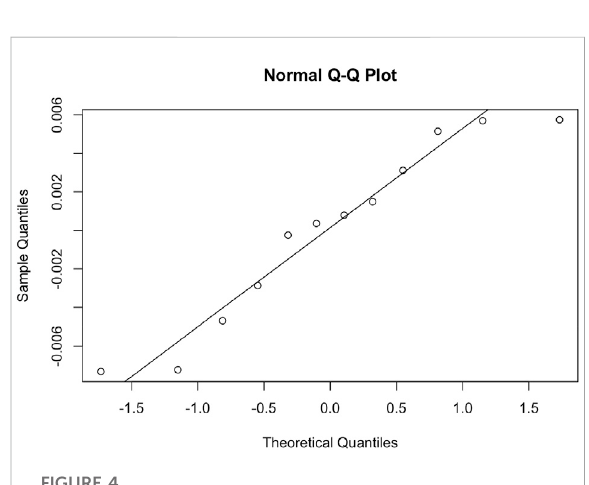
FIGURE 4 Q-Q normal plot of model residuals for the quadratic